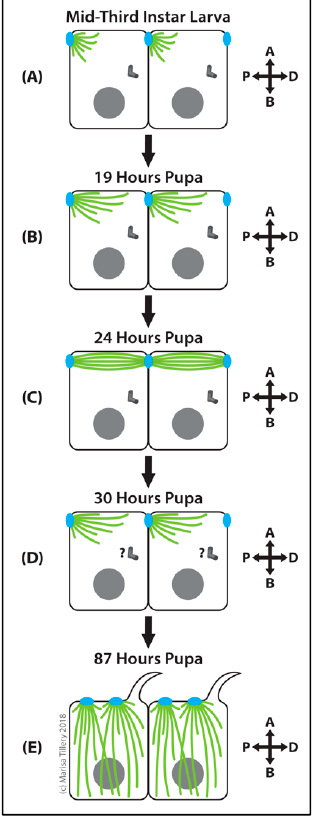
Figure 10. Wing epithelial cell ncMTOC. During larval and early pupal stages ( A – C ), wing epithelial cells employ an apical junction to assemble a dynamic ncMTOC along the proximal–distal axis that controls planar cell polarity. By 30 h into pupal development ( D ), the MT array loses its ordered proximal–distal organization. At the final stages of wing morphogenesis ( E ), a ncMTOC forms at the apical surface of trichome-bearing cells and organizes MT arrays along the apical–basal axis. The ncMTOC is blue; MTs are green; nuclei and centrosomes are